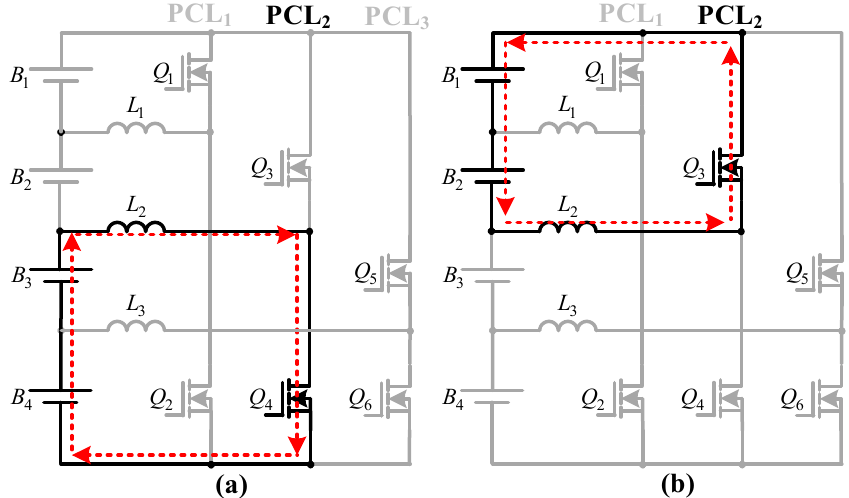
Figure 5. Operation of sub-pack-to-cell (SP2C) mode: ( a ) EC of subinterval 1, ( b ) EC of subinterval 2.